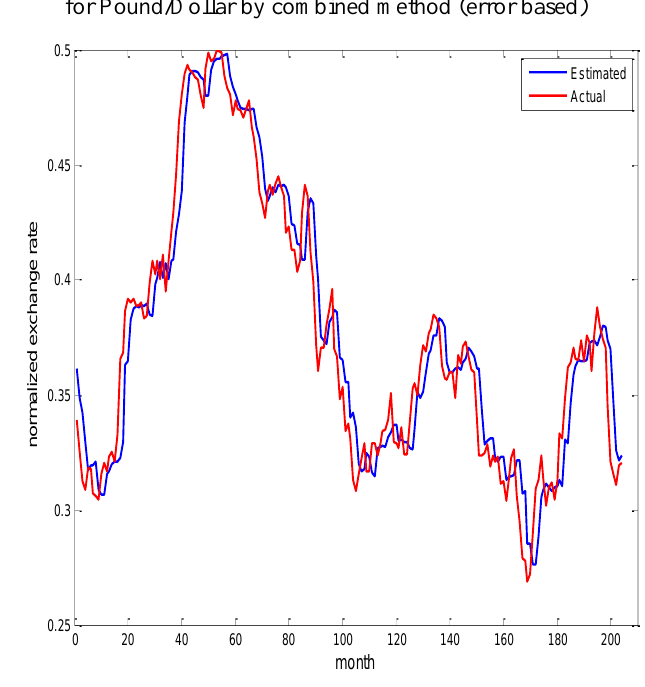
Figure 13 . Actual v/s estimated exchange rate prices for Yen/Dollar by combined method (error